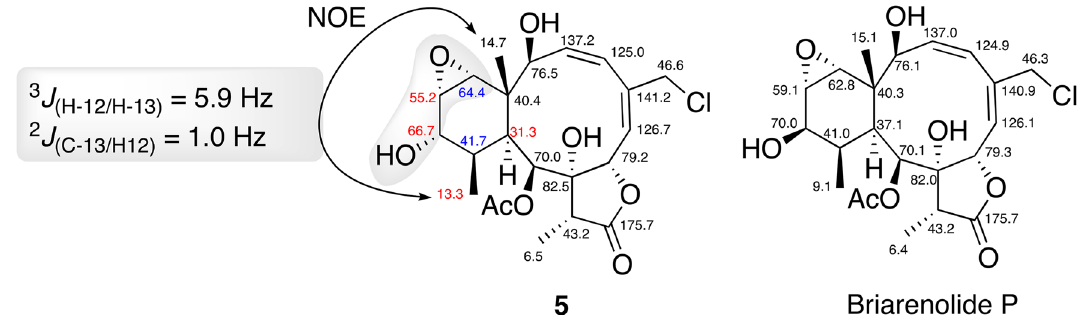
Figure 6. Comparison of the 13 C NMR data between 5 and briarenolide P 27 (carbon chemical shift differences: Δδ C > 3 ppm in red and Δδ C between 0.5 to 1.8 ppm in blue), key coupling constants (see reference 18 ) and NOE correlations in 5. Figures were created with Chemdraw 20.0 and Chem3D